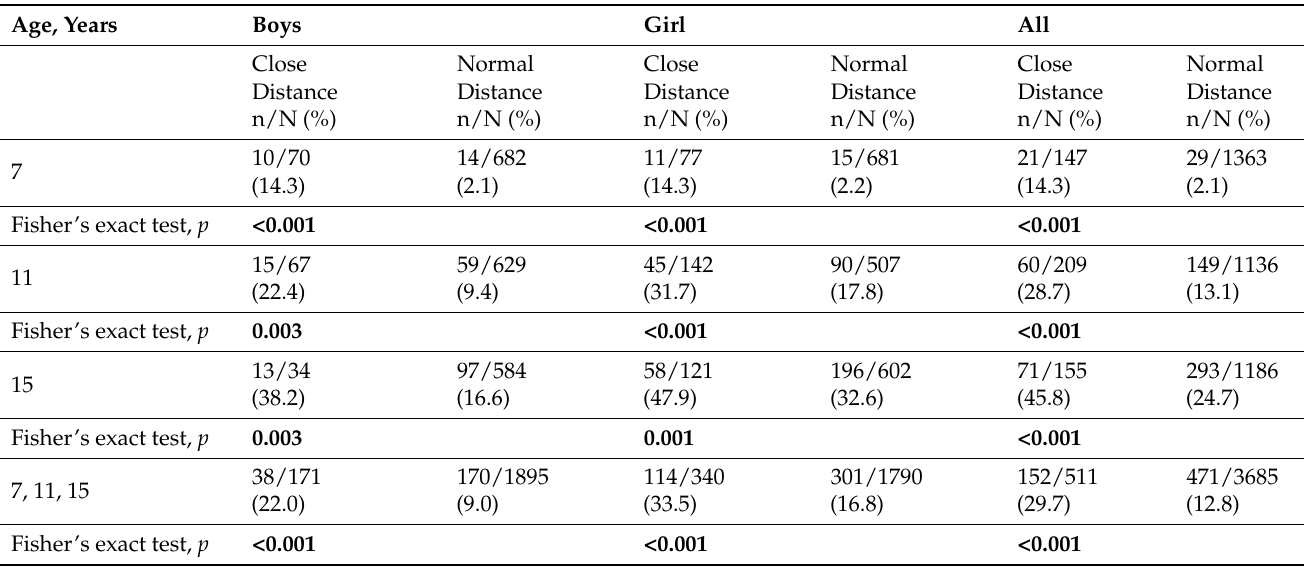
Table 3. Prevalence of child myopia according to parents’ estimates of their child’s close reading